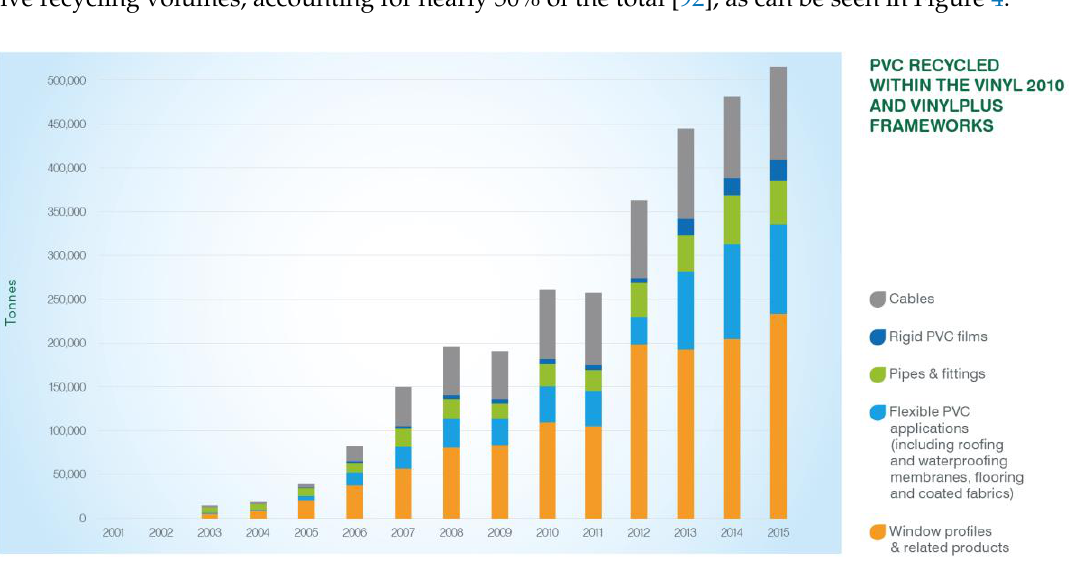
Figure 3. Pictogram for marking PVC products containing recovered PVC (2001 = 100%) [90].